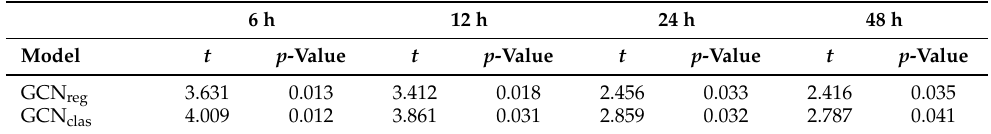
Table 5. t -test for comparing our model with graph-based models without spatio-temporal attention for 6h, 12h, 24h and 48h forecasts.